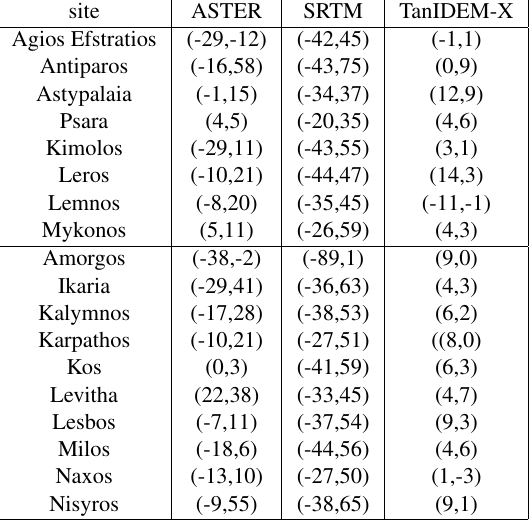
Table 5. Systematic translation (DX, DY) of the global DEMs with respect to local elevation data.